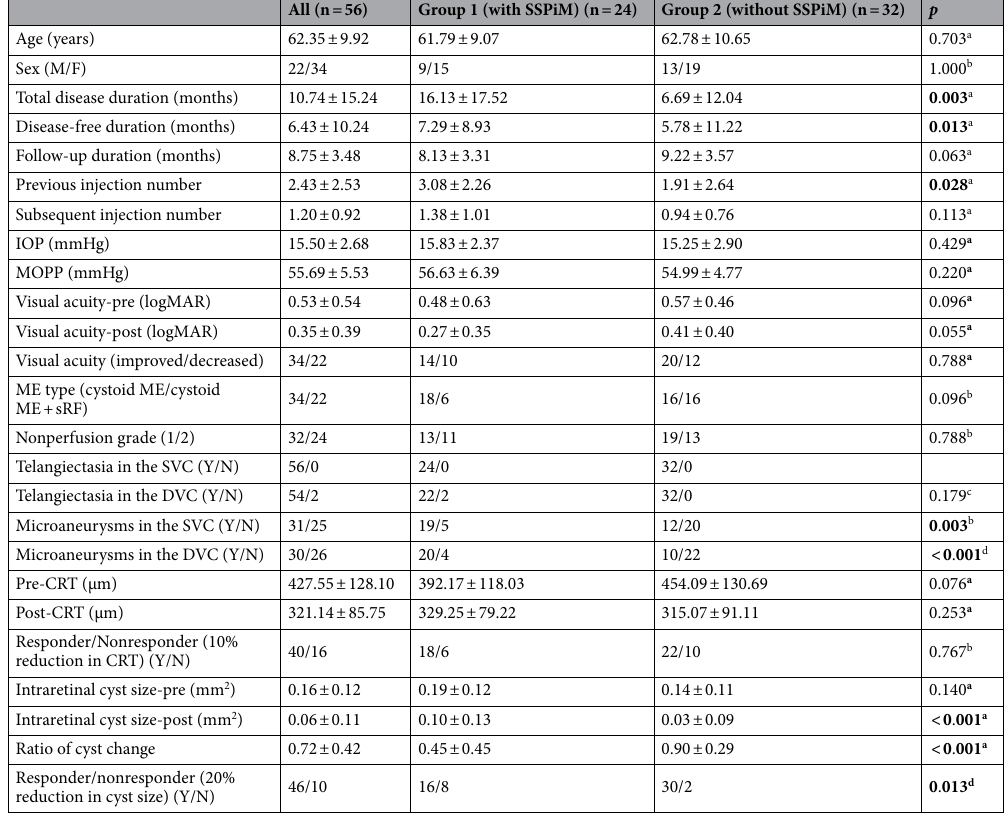
Table 1. Comparison of basic characteristics between group 1 (patients with suspended scattering particles in motion (SSPiM)) and group 2 (those without SSPiM). SSPiM suspended scattering particles in motion, M male, F female, IOP intraocular pressure, MOPP mean ocular perfusion pressure, logMAR log of the minimum angle of resolution, ME macular edema, sRF subretinal fluid, SVC superficial vascular complex, DVC deep vascular complex, Y yes, N no, CRT central retinal thickness. a Mann–Whitney U test. b Pearson K square test. c Linear-by-linear test. d Fisher’s exact